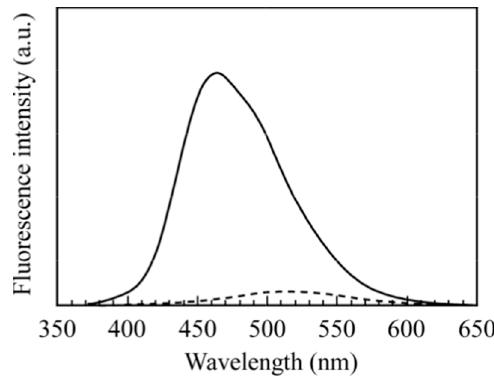
Figure 5. Fluorescence spectra for ANS in the absence (---) and presence (—) of PAMPS–PAaU in 0.1 M NaCl aqueous solutions at pH 3.